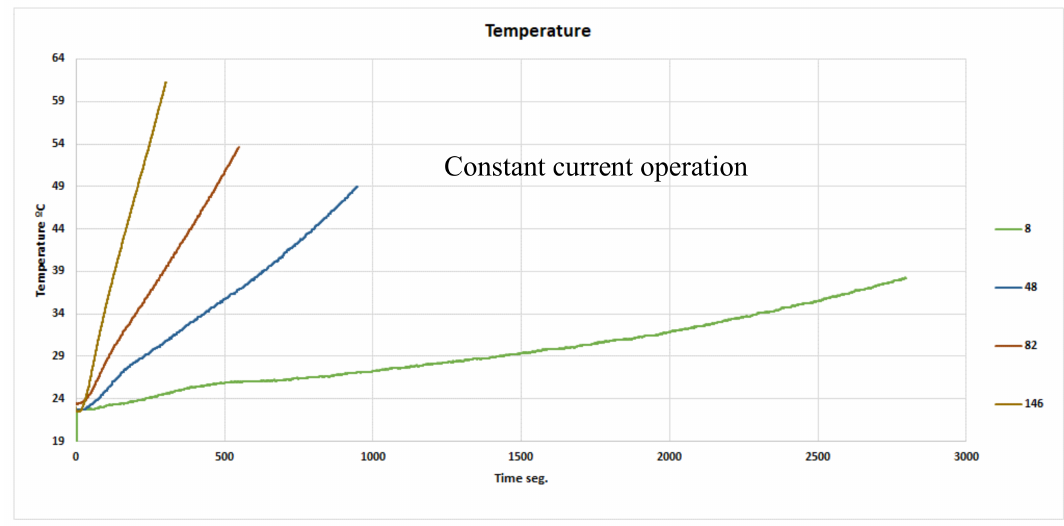
Figure 2. Battery temperature vs. time for several constant current levels (8–140 A).